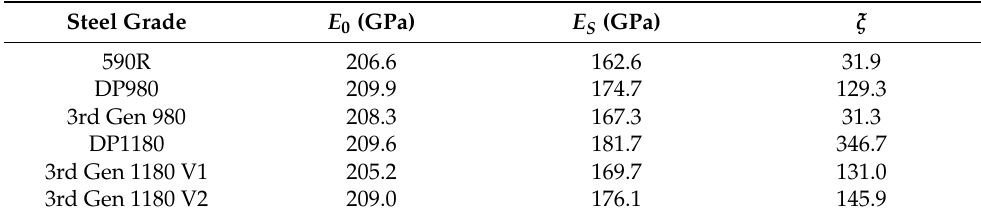
Table 4. Calibrated coefficients for the empirical Yoshida model [29] to capture the chord modulus evolution with pre-strain. Note that interrupted tensile tests were not performed for the DP980 and DP1180. The DP980 and DP1180 data below was digitized from the study of Cobo et al. [31] and calibrated to Equation (6).